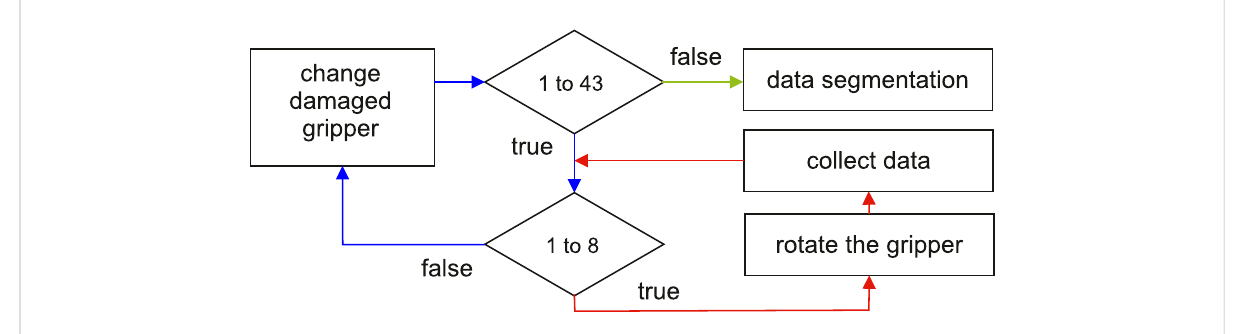
FIGURE 3 Datacollectionprocedure.The43damagecombinationsarecollectedbymanuallyreplacingthe fi ngersoftheFinRaygripper(seeredline).For each damage combination, the robot collected data for eight roll angles of the gripper. The collected data are further segmented into 125-point- long signals using the sliding window strategy with the 10 points of the shift step between each pair of consecutive segments.